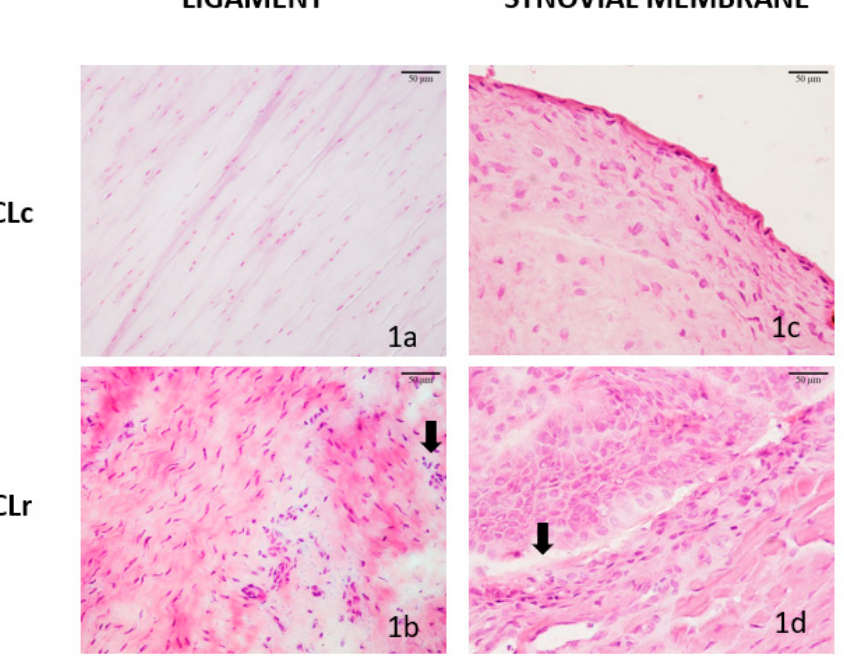
Figure 1. Histological features of canine cruciate ligaments (CCL) and synovial membranes (SM) in the controls (CCLc) and in remnants of ruptured ligaments (CCLr): ( a ) CCLc, case 3, collagen fibers longitudinally oriented with spindle-like fibrocytes in alignment with fibers; ( b ) CCLr, case 2, disorganization of collagen fibers, infiltration with lymphocytes and some polymorphonuclear granulocytes (arrow); ( c ) SM control (SMc) case 3, a monolayer of histiocytes and fibrocytes overlaying loose capsular tissue; ( d ) Altered SM (SMr) of case 2 with CCLr: thickening of synovial membrane, synovioblast proliferation, diffuse infiltration of lymphocytes and polymorphonuclear granulocytes (arrow), and angiogenesis, characterized by numerous small vessels. Hematoxylin and eosin staining, scale bars 50 µ